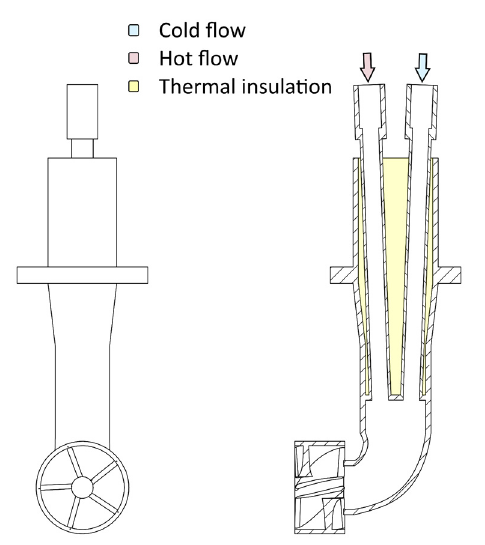
Figure 15. Definitive EWG injector scheme.